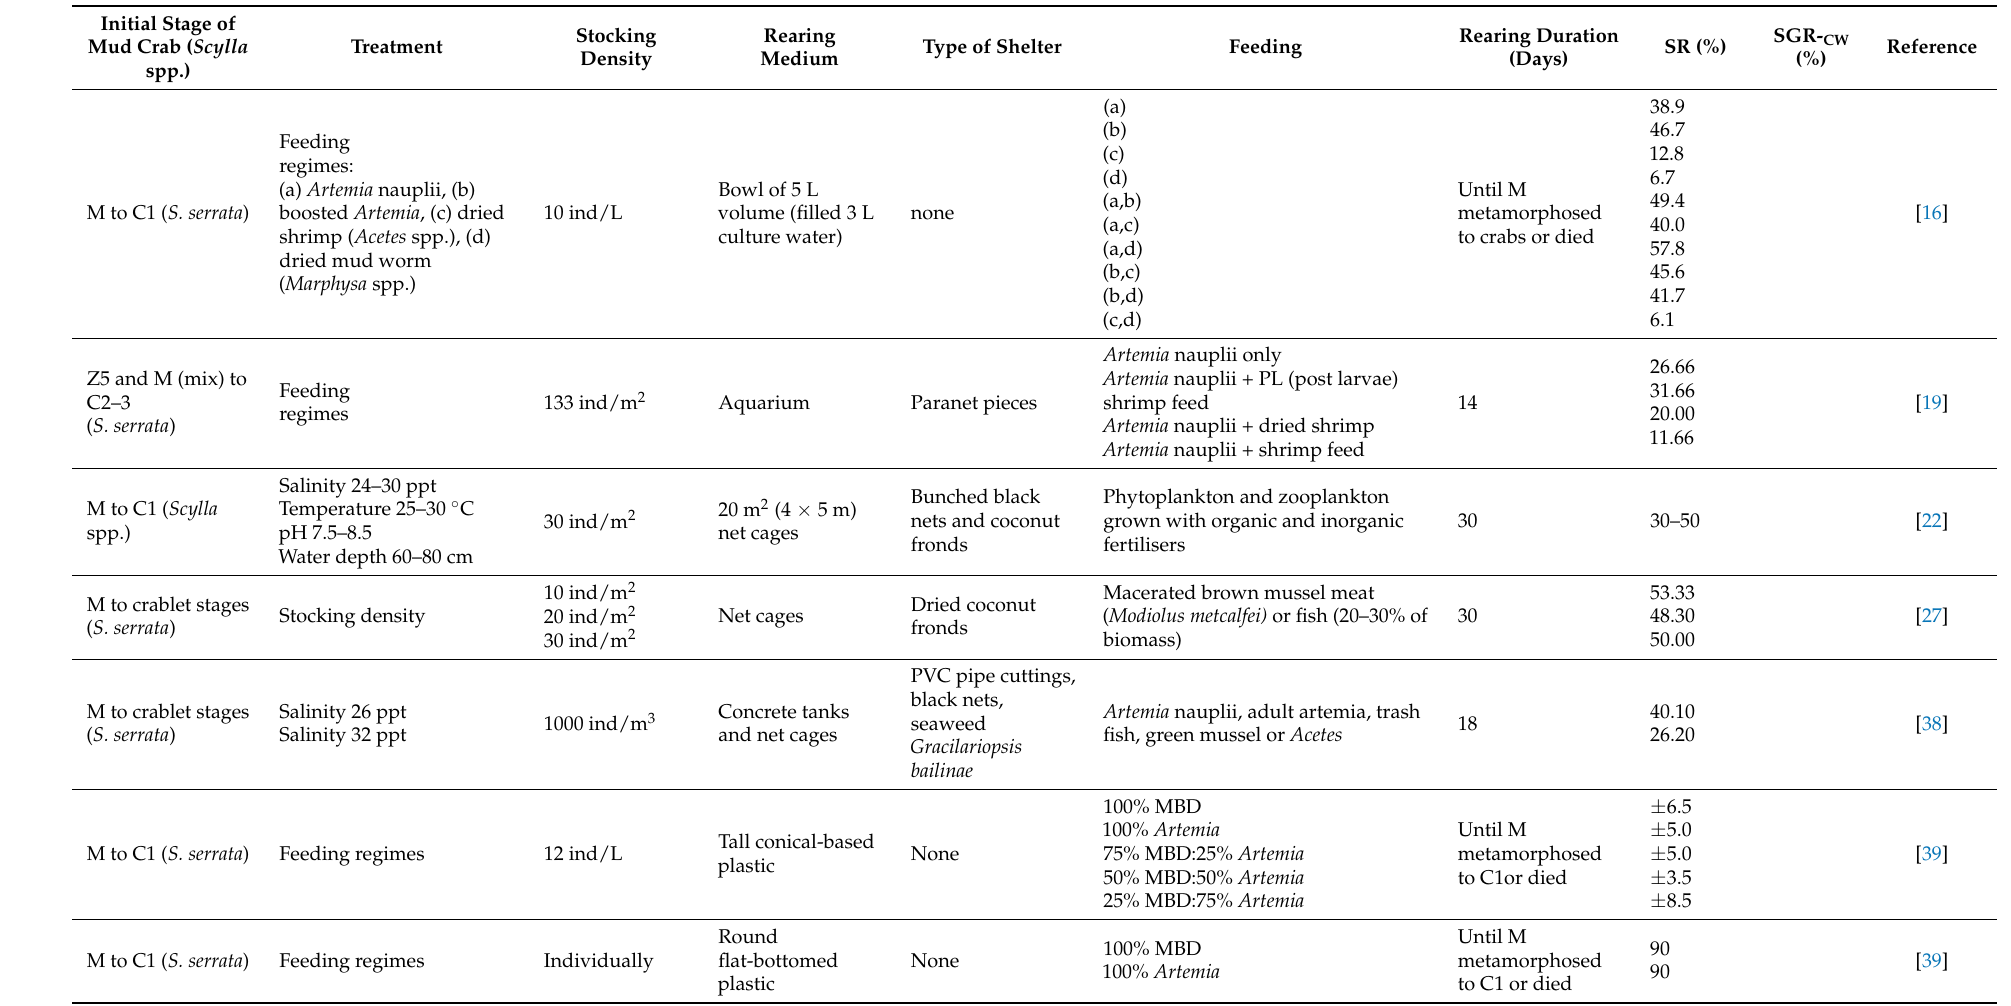
Table 2. Summary of the studies related to the nursery of mud crabs ( Scylla spp.) starting at megalopa and crablet stages with a different treatment (stocking density, rearing medium, type of shelter or feeding regimes) and the effect on the survival rate. Initial Stage of Mud Crab ( Scylla